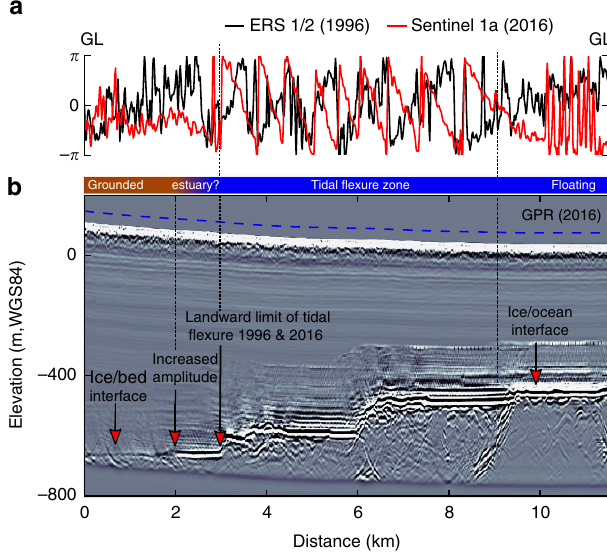
Figure 3 | Characterization of the grounding zone. Satellite radar interferometry from 1996 and 2016 ( a ) together with ground-penetrating radar (GL-GL 0 located in Fig. 1) ( b ). Radar reflection amplitudes suggest basal water upstream of the tidal flexure limit, potentially indicating an estuary with intrusion of ocean water. The blue dashed curve delineates the